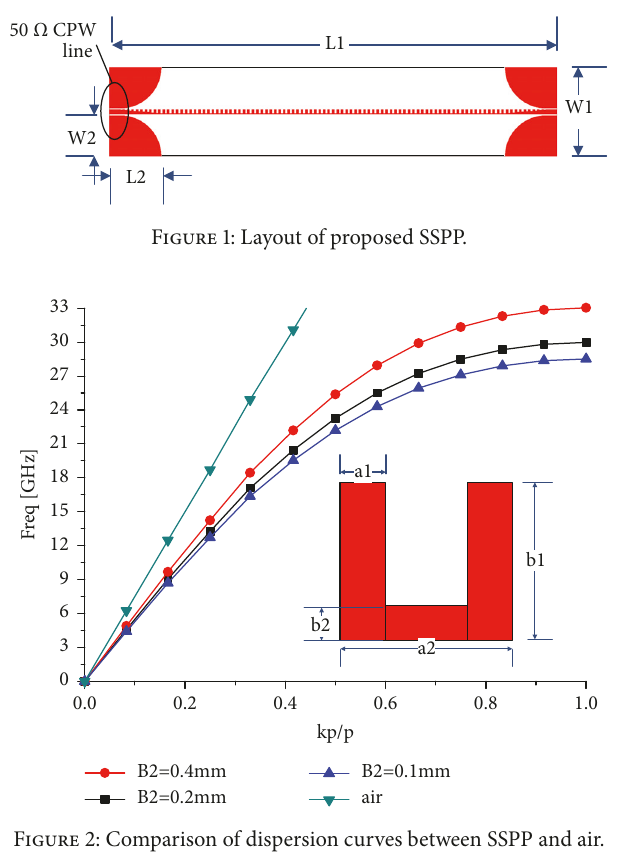
Figure 2: Comparison of dispersion curves between SSPP and